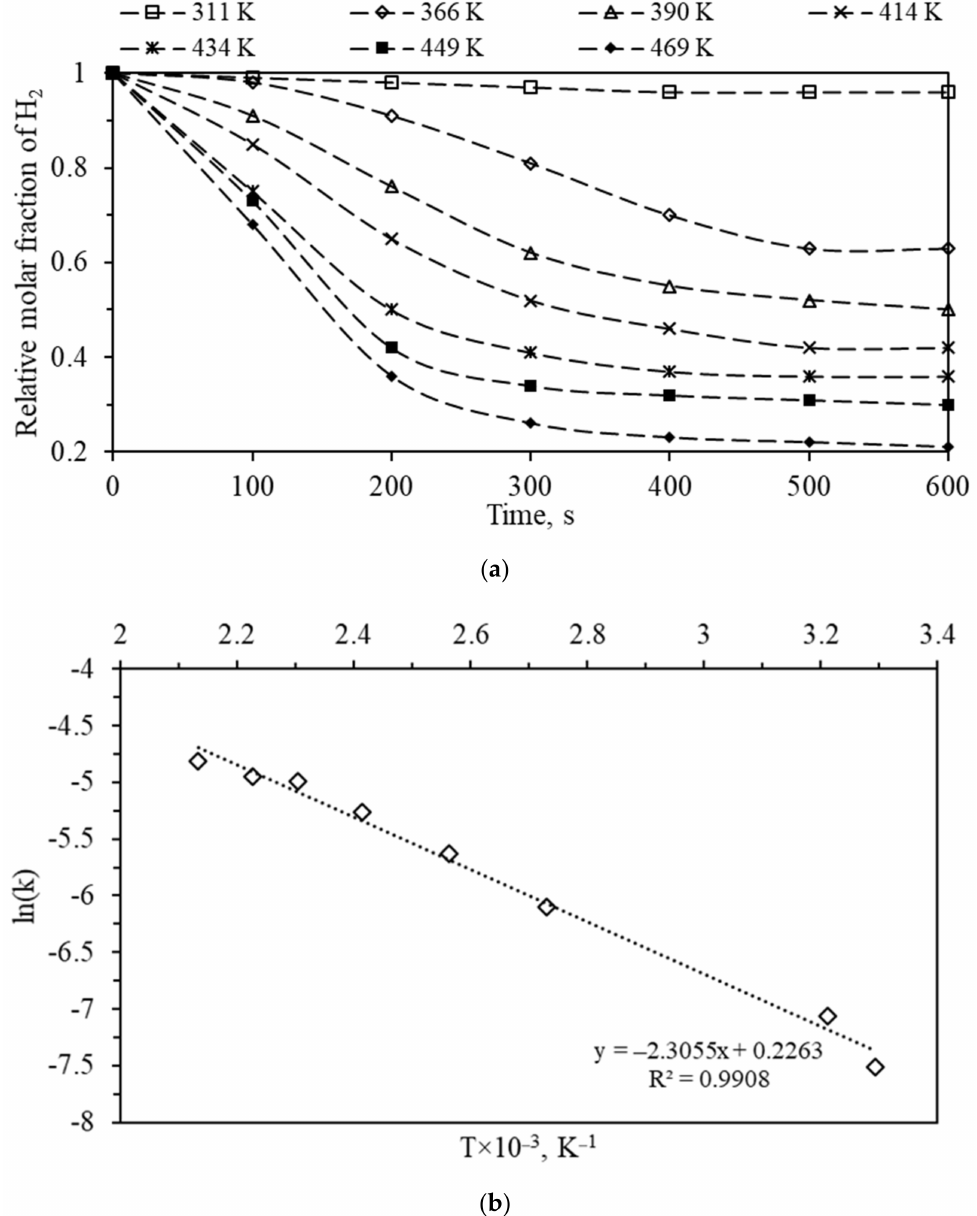
Figure 4. ( a ) Relative molar fractions of H 2 as a function of time at constant temperatures under steady-state conditions; ( b ) Arrhenius plot for CHC on the Pt/AAO